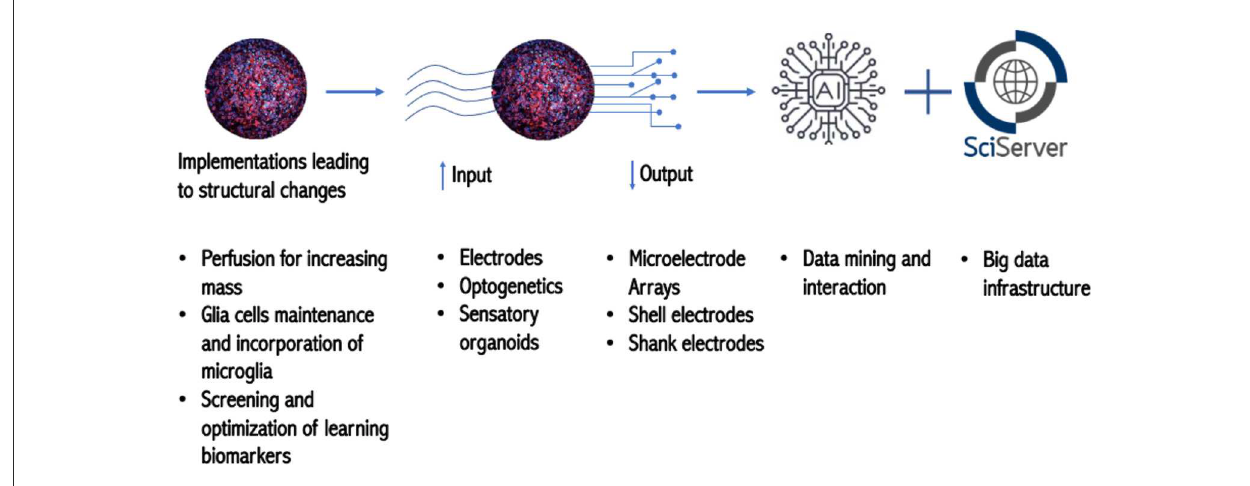
FIGURE2 Roadmap toward